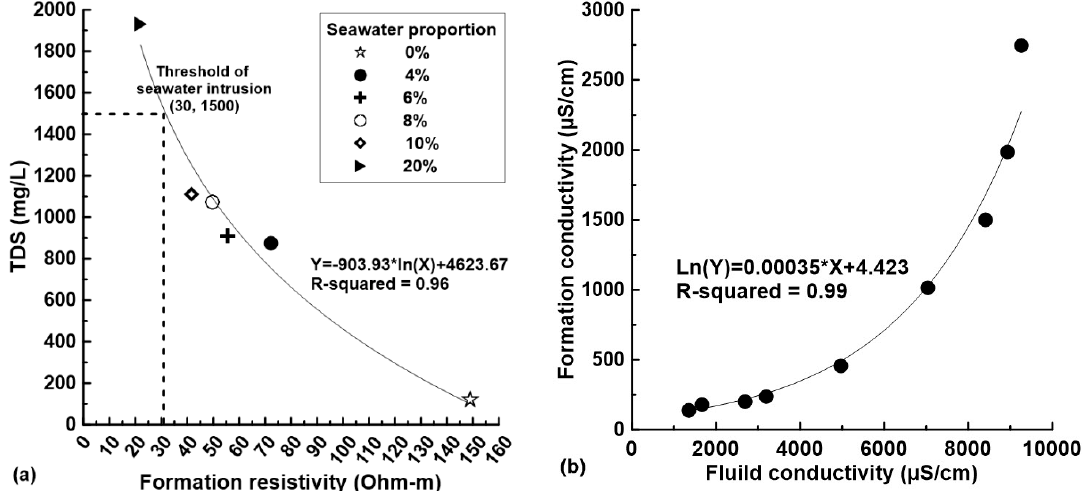
Figure 5. Cross-correlation between: ( a ) formation resistivity and TDS and ( b ) formation and fluid resistivity.